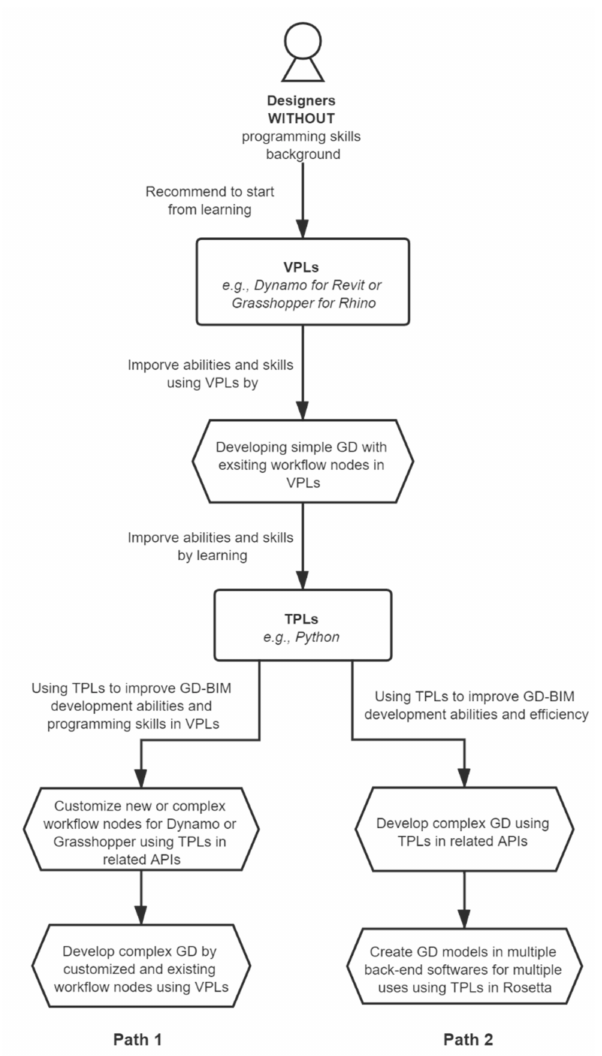
Figure 5. Paths of skill learning and improving GD-BIM development for